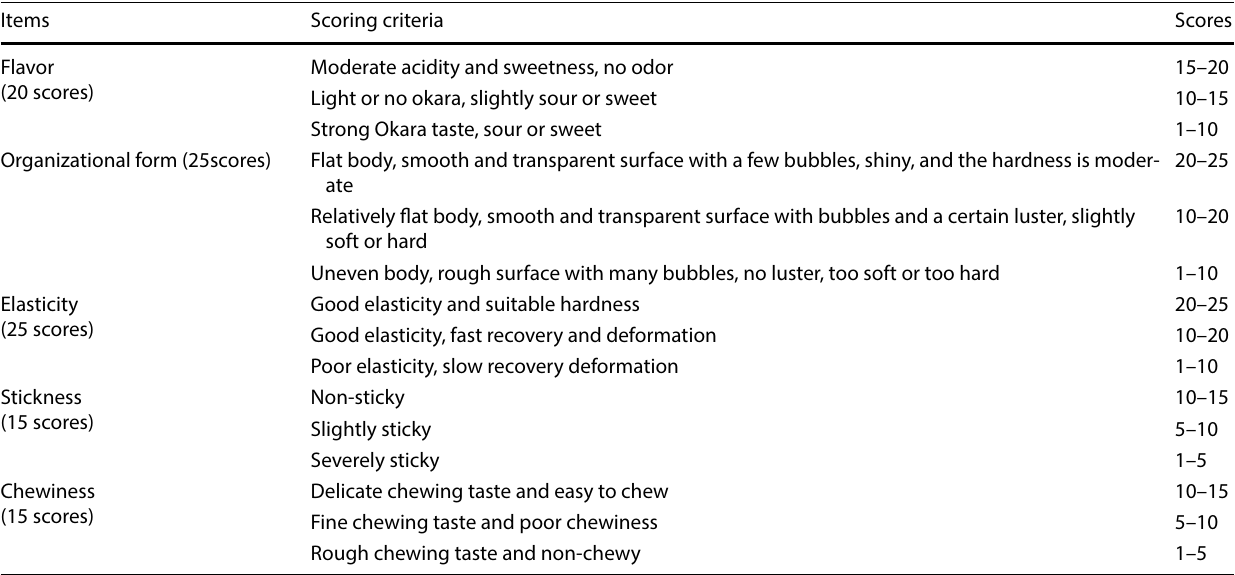
Table 2 Sensory quality scoring criteria for OP gel gummies